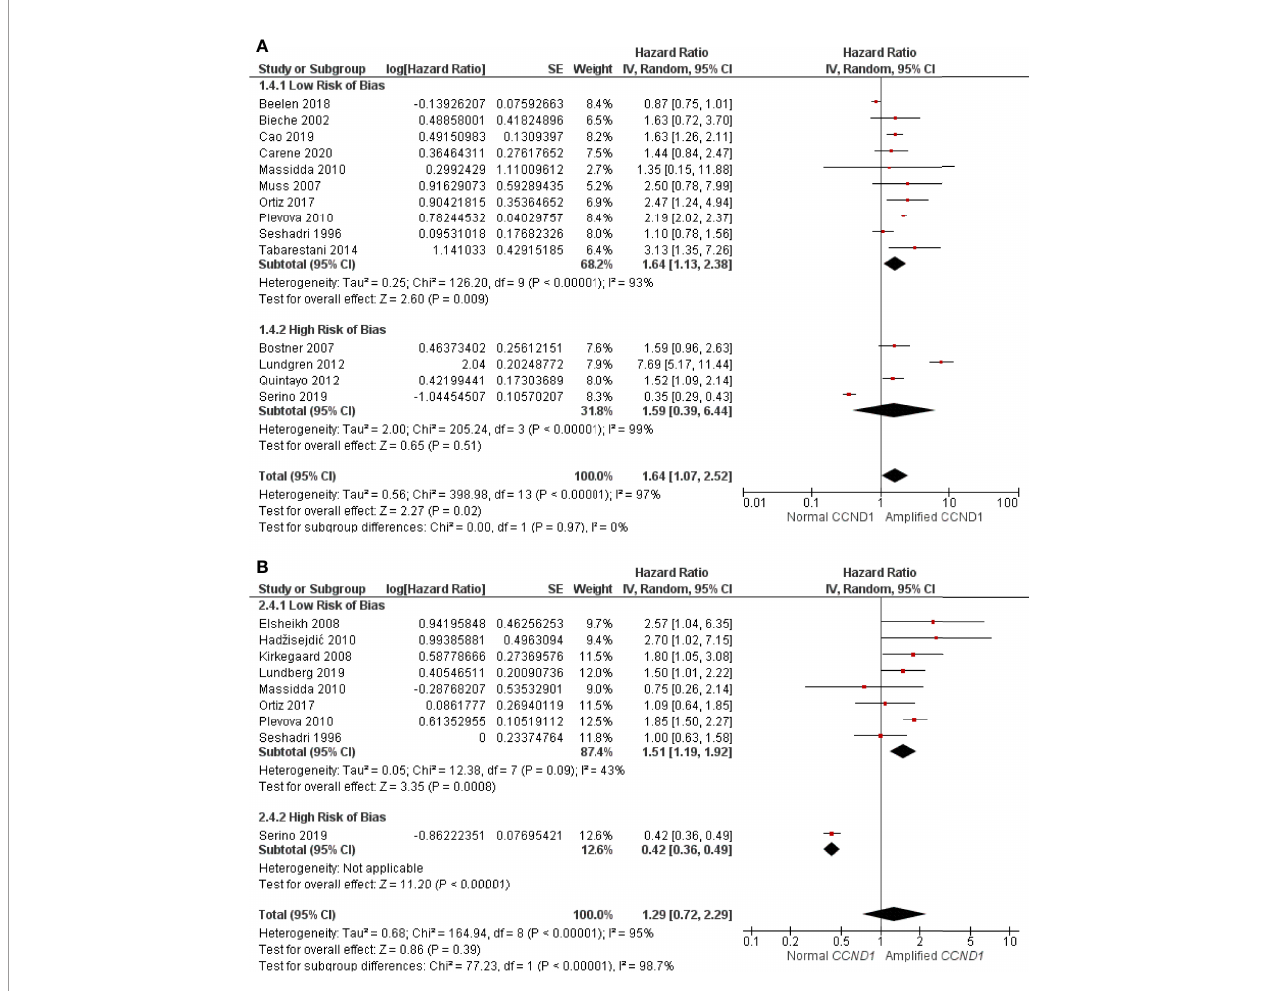
FIGURE 3 | Forrest plot of hazard ratios for CCND1 ampli fi cation and worse relapse free survival and overall survival of breast cancer patients. (A) CCND1 Ampli fi cation and relapse free survival (B) CCND1 Ampli fi cation and overall survival. Z values indicate the magnitude of association, with p-values <0.05 indicating statistically signi fi cant association. Red squares indicate hazard ratio, with values >1 indicative of association of the outcome measure (RFS and OS) with CCND1 ampli fi cation, with strongest association towards the right of the plot. Black lines either side of squares indicate 95% con fi dence interval (CI). Size of red boxes is relative to speci fi c study weight with greatest weight given to studies with minimal variance (calculated based on inverse of the variance). Large black diamond represents pooled hazard ratio estimate of the above studies. A random effects approach was taken. SE, Standard Error. Plots were generated in Review